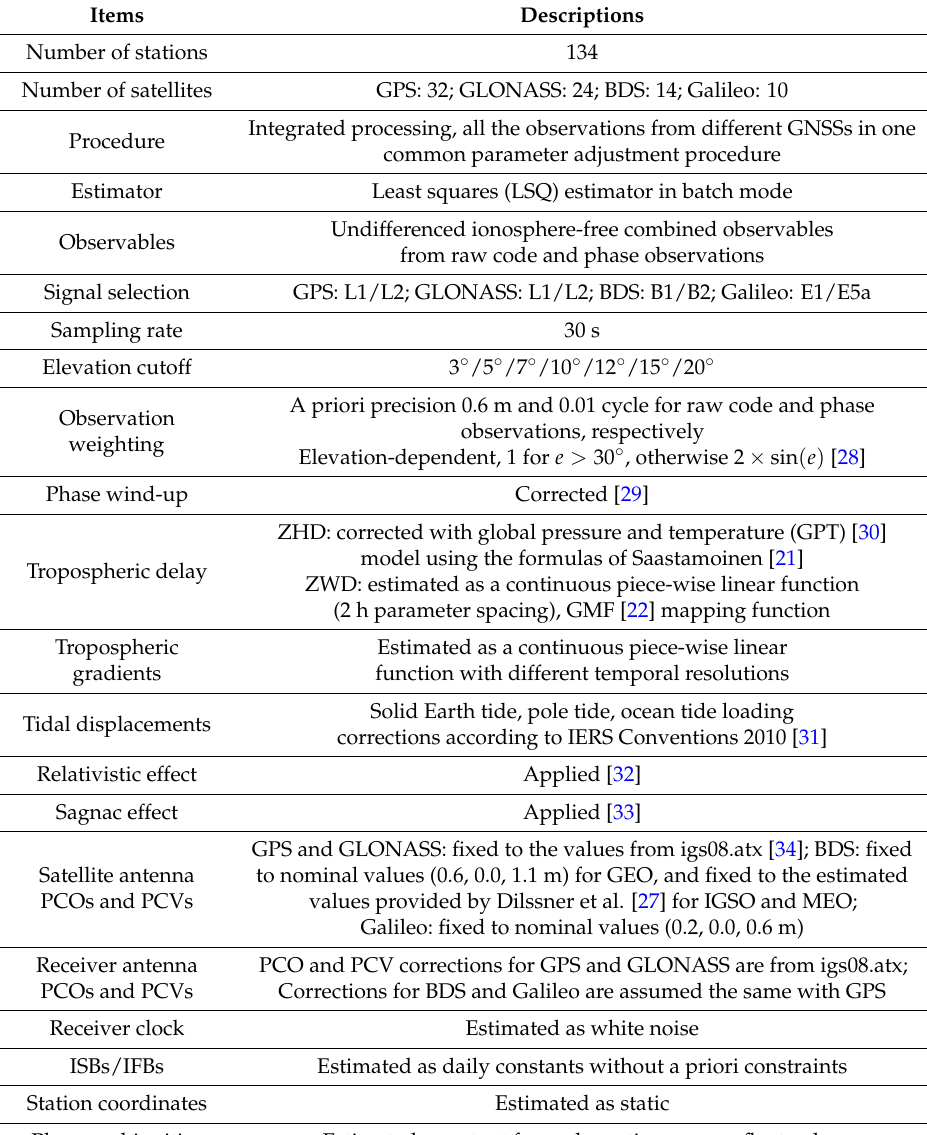
Table 1. Summary of multi-GNSS PPP processing